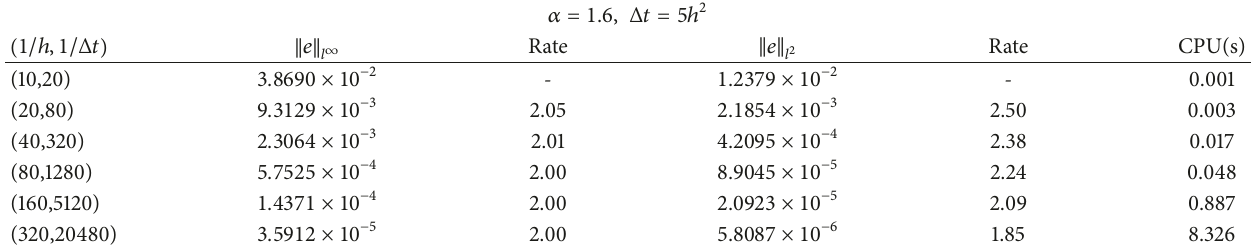
Table 3: Error and convergence rates for Example 1. 𝛼 = 1.6, Δ𝑡 = 5ℎ